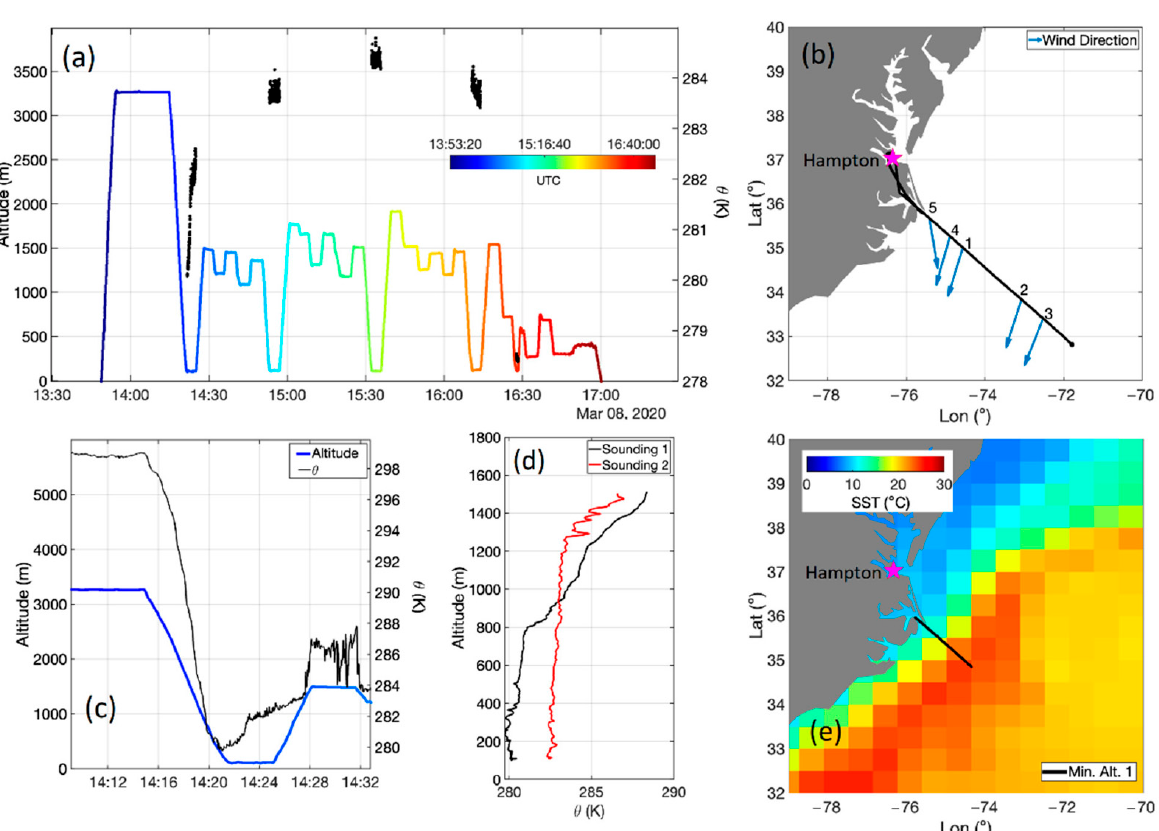
Figure 5. ( a ) Time series of the HU-25 Falcon altitude (left y-axis; colored by UTC time) and measured potential temperature during Min. Alt. legs (right y-axis; black markers) of research flight 17 on 8 March 2020. ( b ) Flight tracks for the entire flight with the numbers corresponding to each Min. Alt. leg in order from 1 to 5, with the median wind direction along each of those five legs shown by arrows. ( c ) Time series of Falcon altitude and potential temperature during a slant descent followed by a Min. Alt. leg (i.e., Min. Alt. 1 in panel ( b )) and then an ABL leg during a cloud-free period. ( d ) Two vertical profiles of potential temperature using data from the slant descent before the first Min.